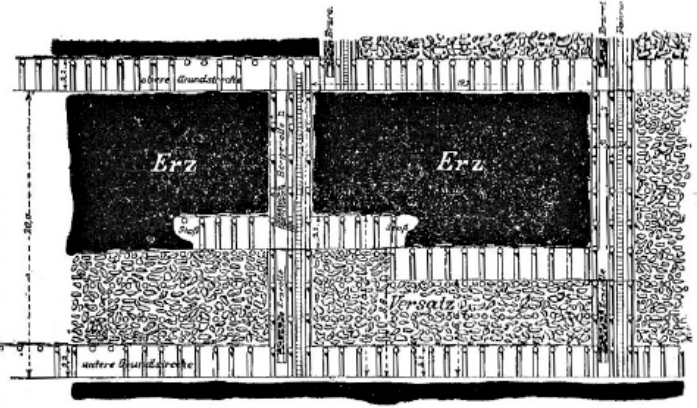
Figure 5. Floor-and-wall mining system